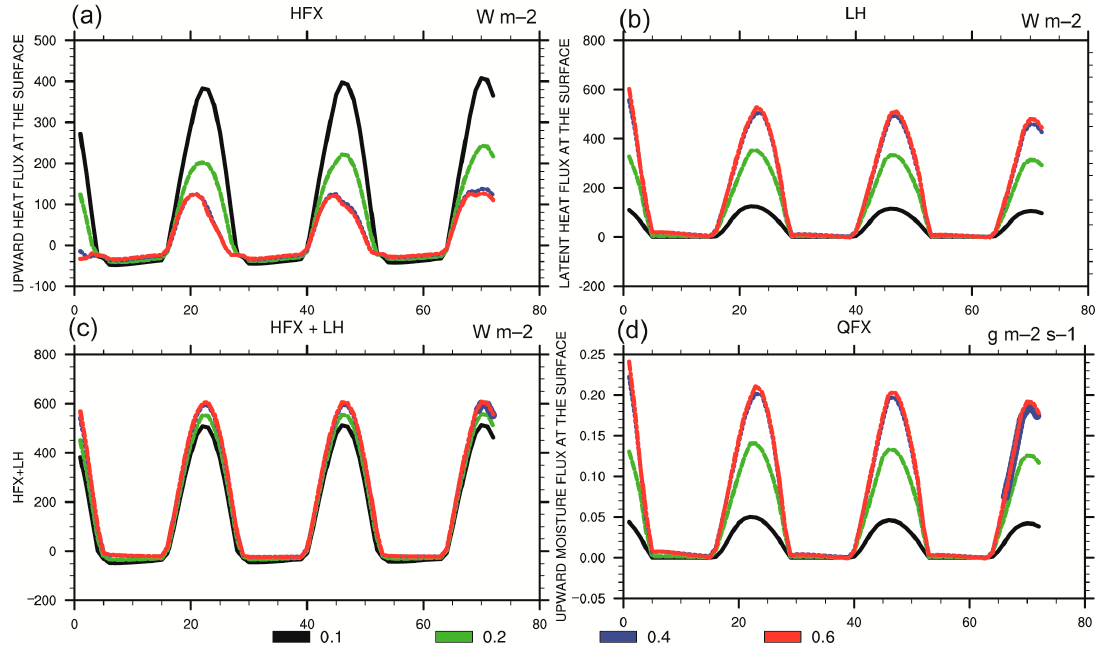
Figure 4. The ( a ) sensible heat fluxes (SHFs); ( b ) latent heat fluxes (LHFs); ( c ) LHFs + SHFs and ( d ) upward moisture fluxes at the ground surface (QFXs) of the SCM simulations under different soil moisture initial conditions. The black line represents the soil moisture equal to 0.1; the green line represents the soil moisture equal to 0.2; the blue line represents the soil moisture equal to 0.4; and the red line represents the soil moisture equal to 0.6. The x -axis represents the number of hours since the simulation.